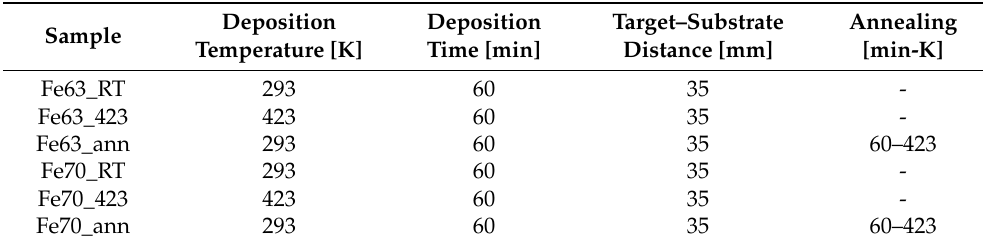
Table 1. Experimental conditions of the thin film